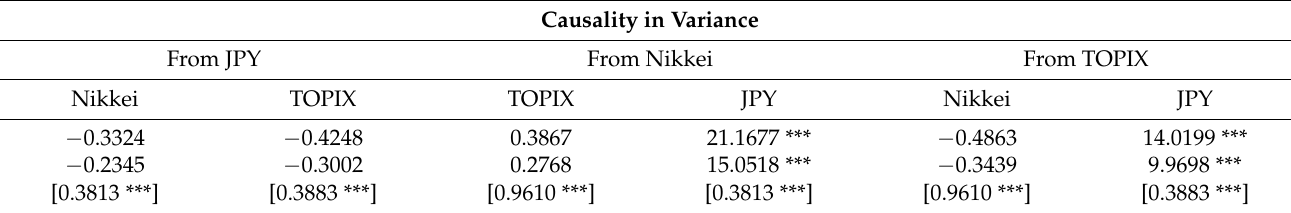
Table 4. Causality relationship among JPY, Nikkei, and TOPIX. Author’s estimations. First line reports Hong’s (2001) Q-statistics with truncated kernel. Second line reports Hong’s (2001) Q-statistics with Bartlett kernel. Third line reports cross-correlation coefficients at lag 0 (contemporaneous correlation). *** means that the null hypothesis of no causality (from lag 1 to lag 10 for Hong’s (2001) Q-statistics) at a 1% significance level is rejected.